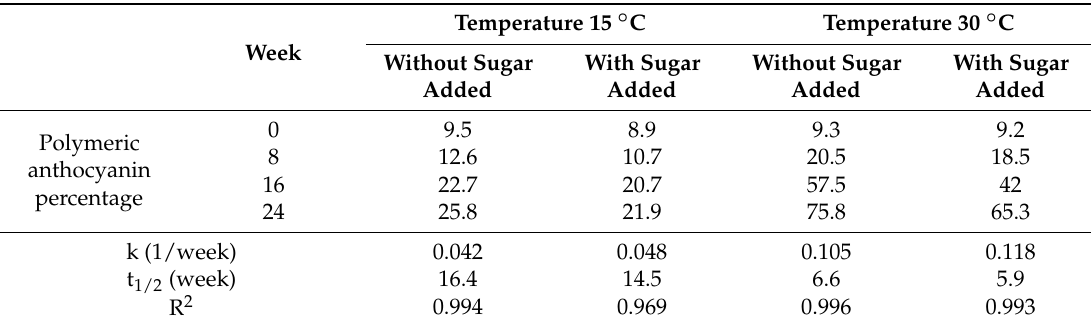
Table 5. Changes of polymeric anthocyanin percentage and the parameters of degradation kinetics of sour cherry liqueurs during storage.